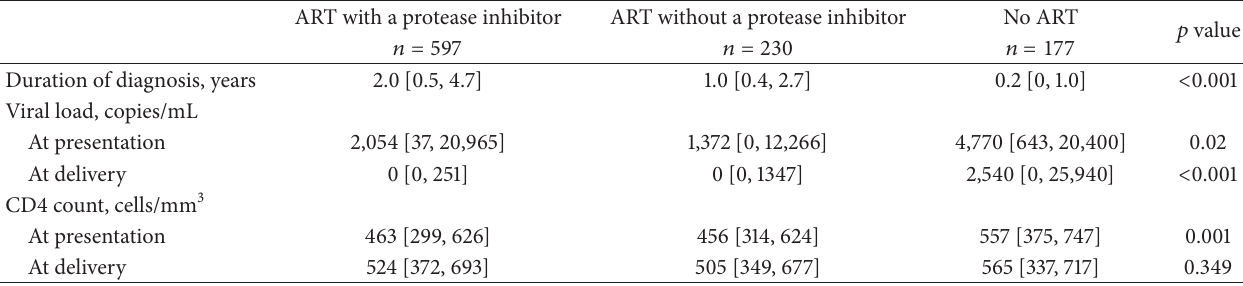
Table 2: Markers of maternal disease status during pregnancy in HIV-infected women by type of antepartum antiretroviral therapy. ART with a protease inhibitor ART without a protease inhibitor